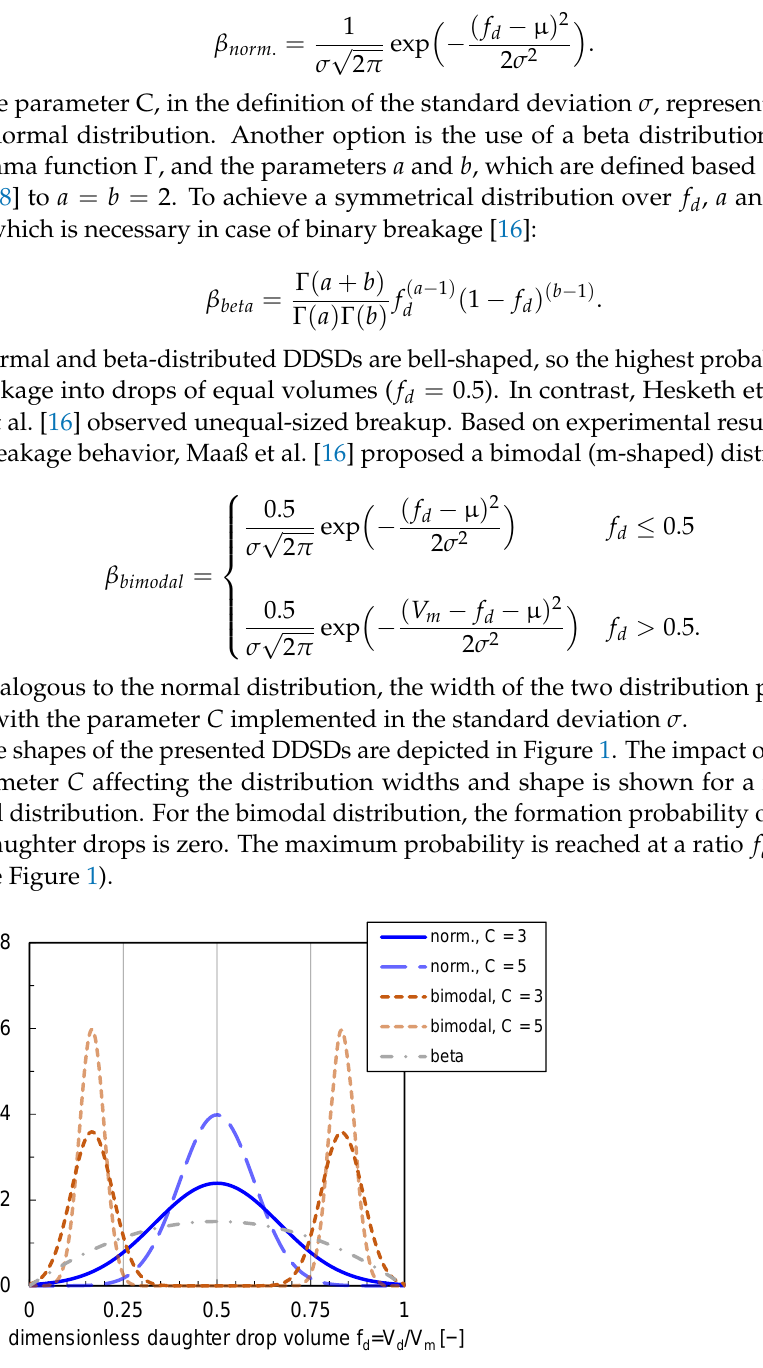
Figure 1. Normal (norm.), bimodal and beta DDSDs. Distributions are plotted with a variety of distribution width ( C = 3 and C = 5) for bimodal and normal